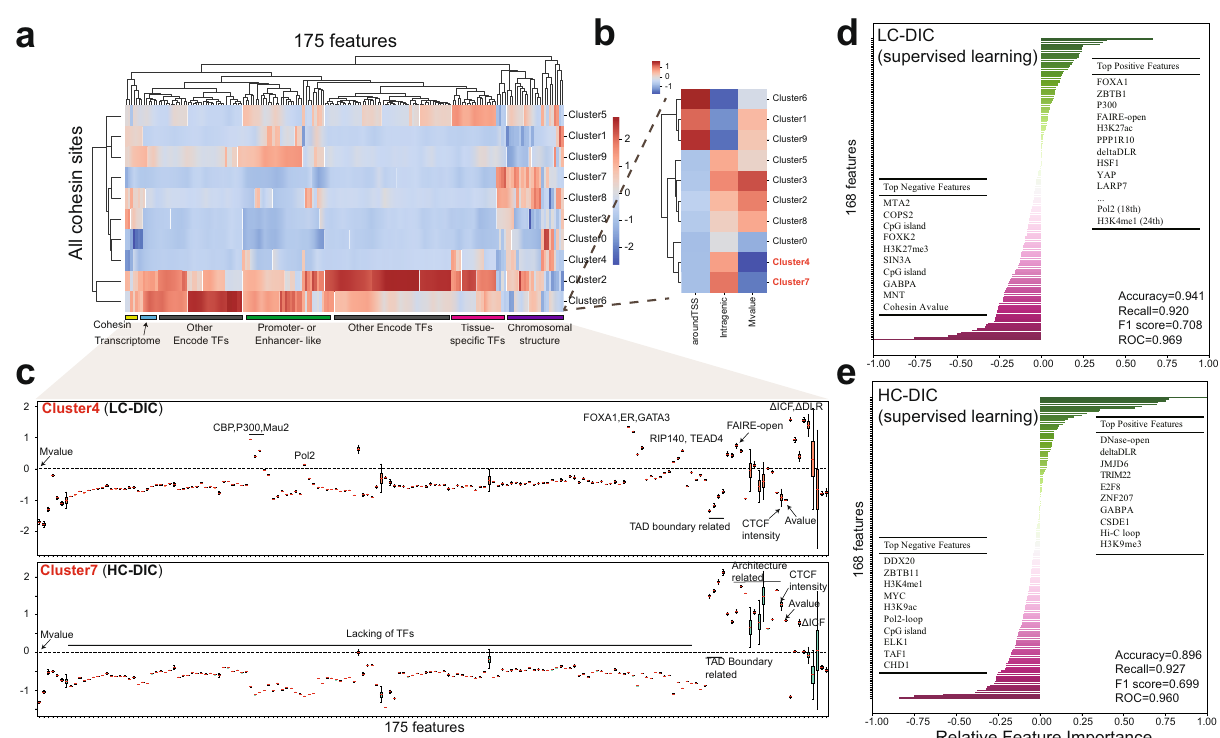
Fig. 4 Machine learning methods to classify DICs. a Cluster heatmap by k-means (k = 10) methods. The 175 features were roughly classi fi ed into different groups. Source data are provided in the Source Data fi le. b Magni fi ed view of the heatmap area shown in A indicates three important features for these 10 clusters: “ aroundTSS ” indicates whether a cohesin site was near TSS; “ intragenic ” indicates whether a cohesin site was within a gene body; “ M value ” is the log 2 ratio of Rad21 peak density between the E2 and control group. c The boxplot of each feature for cluster 4 ( n = 11,920) and 7 ( n = 33,158), where n is the number of cohesin sites. The y axis shows the normalized ( z score) values of binary and continuous features. Box plots indicate the interquartile range IQR (25 – 75%) with a line at the mean. Whiskers indicate 95% con fi dence intervals. d , e The importance of individual features from the logistic regression model for ( d ) LC-DICs and ( e ) HC-DICs. Top positive and negative features are listed inside the plots. Model performance is indicated in the bottom